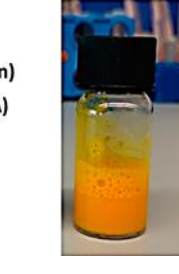
Figure 10. Schematic illustration of fabrication of the nanoconjugate system [94].